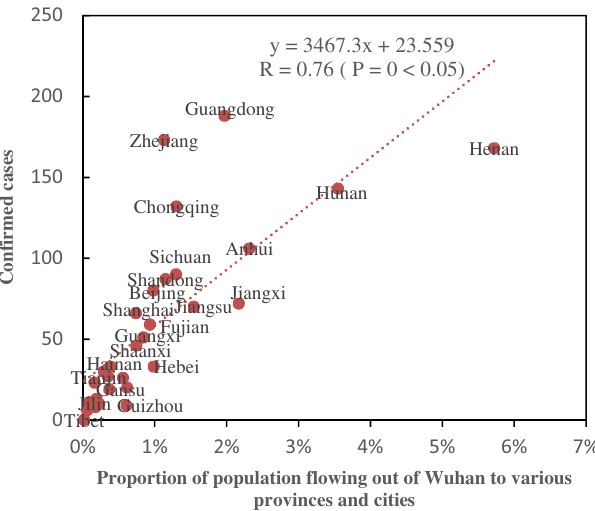
Figure 6. Correlation between the number of confirmed cases in different provinces and the population flow of